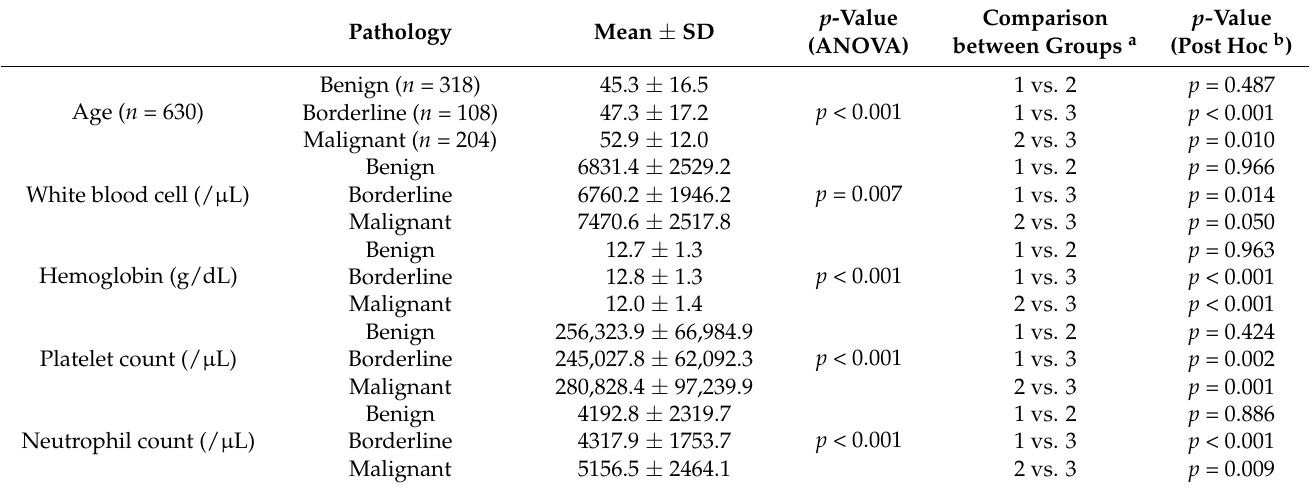
Table 2. Comparison of clinical characteristics and complete blood count among study